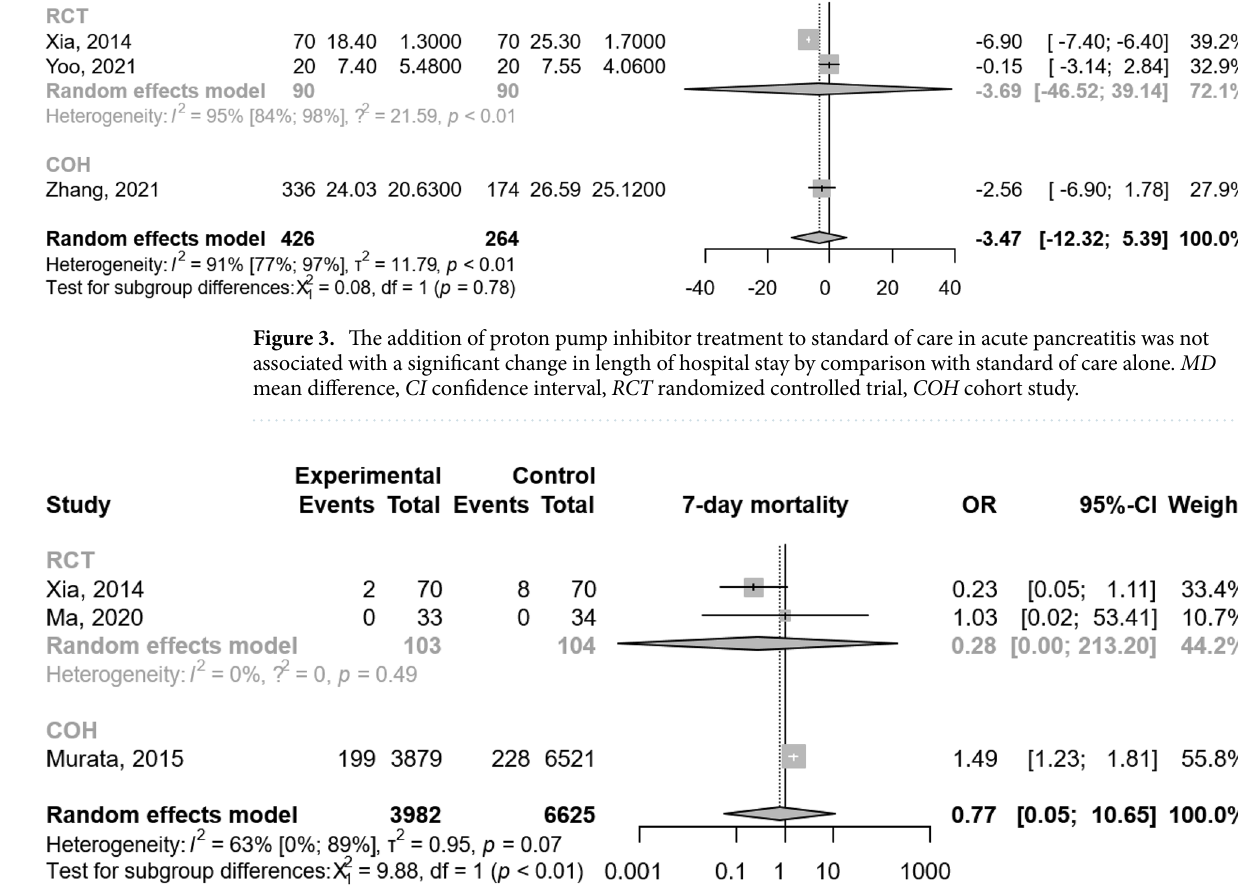
Figure 4. The addition of proton pump inhibitor treatment to standard of care in acute pancreatitis was not associated with a significant change in mortality by comparison with standard of care alone. OR odds ratio, CI confidence interval, RCT randomized controlled trial, COH cohort